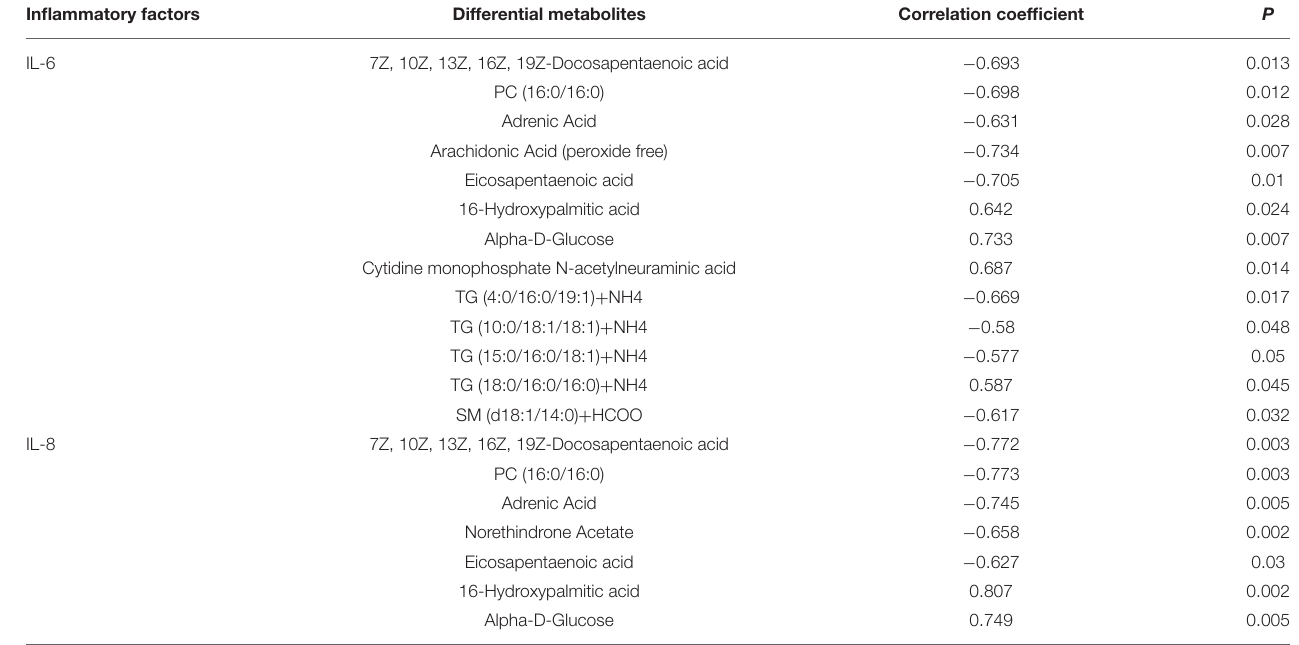
TABLE 6 | Simple correlation analysis between differential metabolites and inflammatory factors. Inflammatory factors